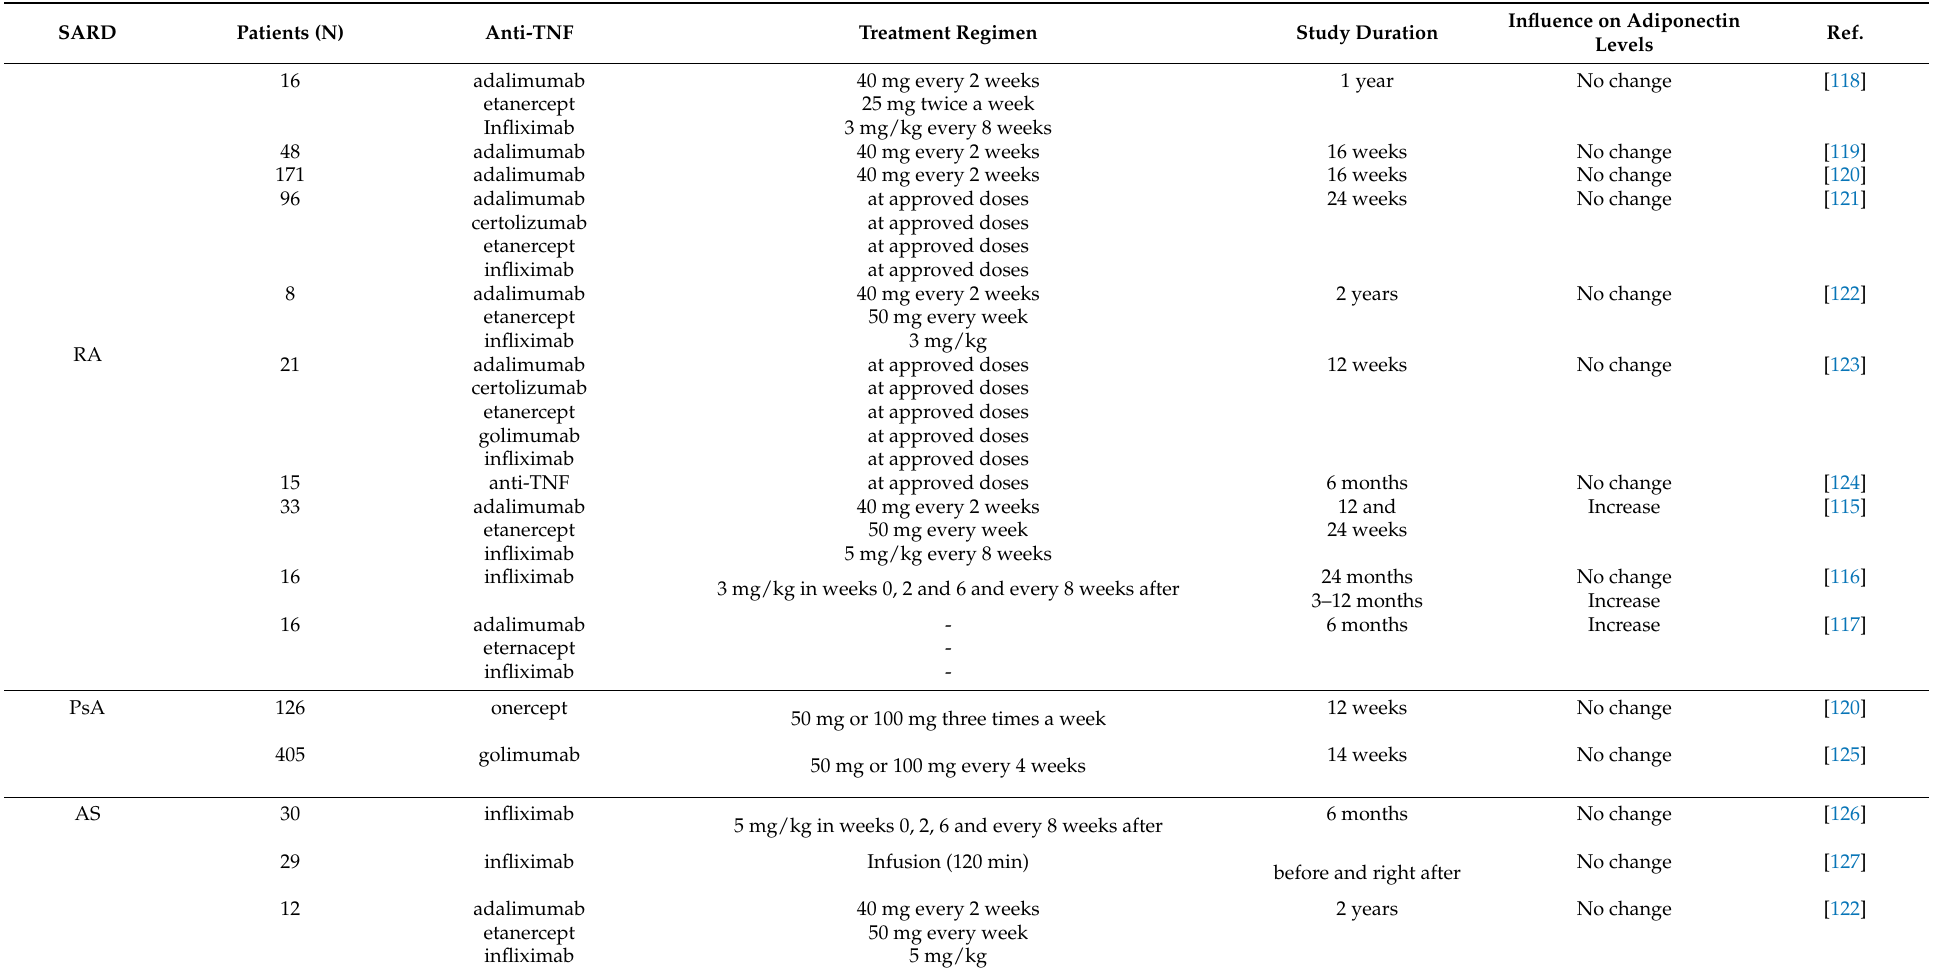
Table 2. Anti-TNF effects on circulating adiponectin levels in rheumatoid arthritis, psoriatic arthritis and ankylosing spondylitis.